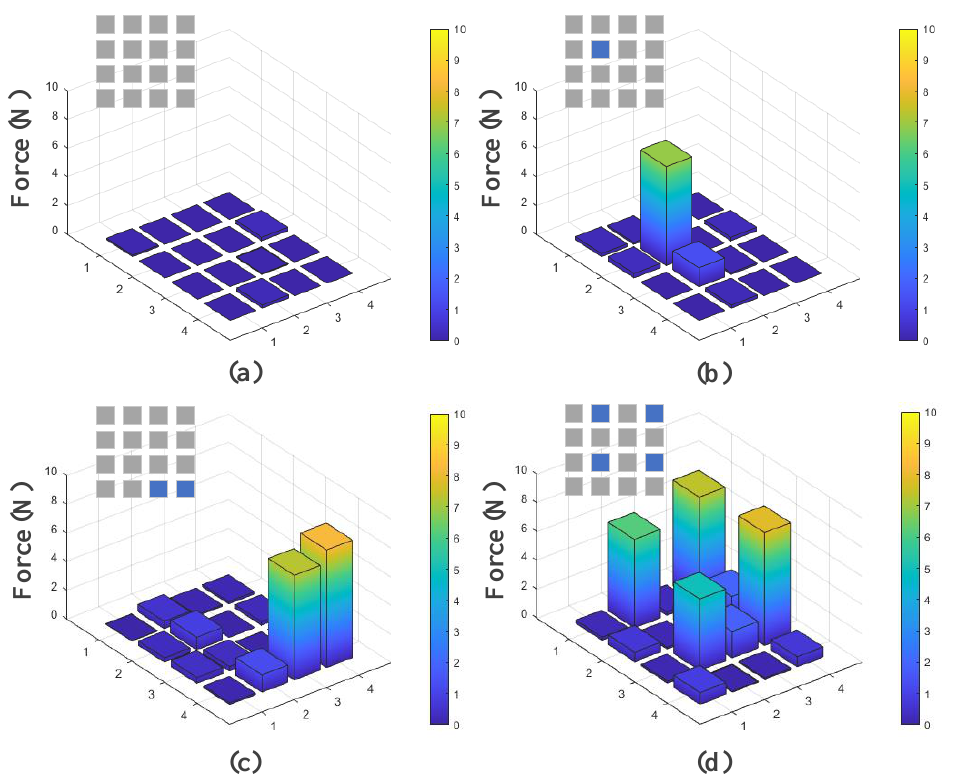
Figure 9. The distribution of the tactile data from the flexible tactile sensor array during finger touch tests under different conditions: ( a ) no sensing units being touched; ( b ) one sensing unit being touched; ( c ) two sensing units being touched; ( d ) four sensing units being